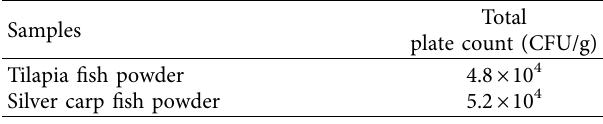
Table 6: Total plate count of Tilapia and Silver Carp fsh powder.